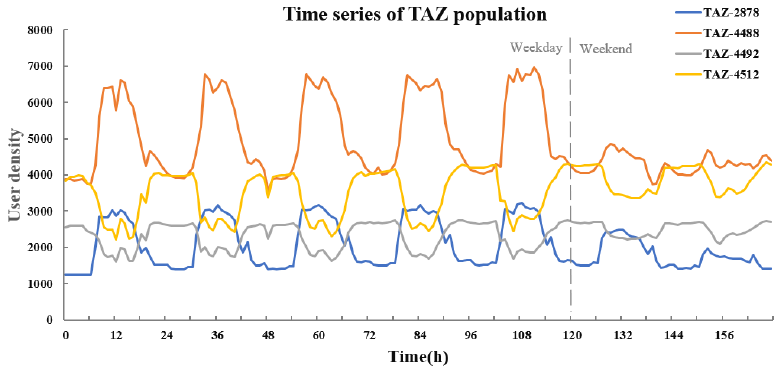
Figure 4. Time series of the user density of different TAZs.